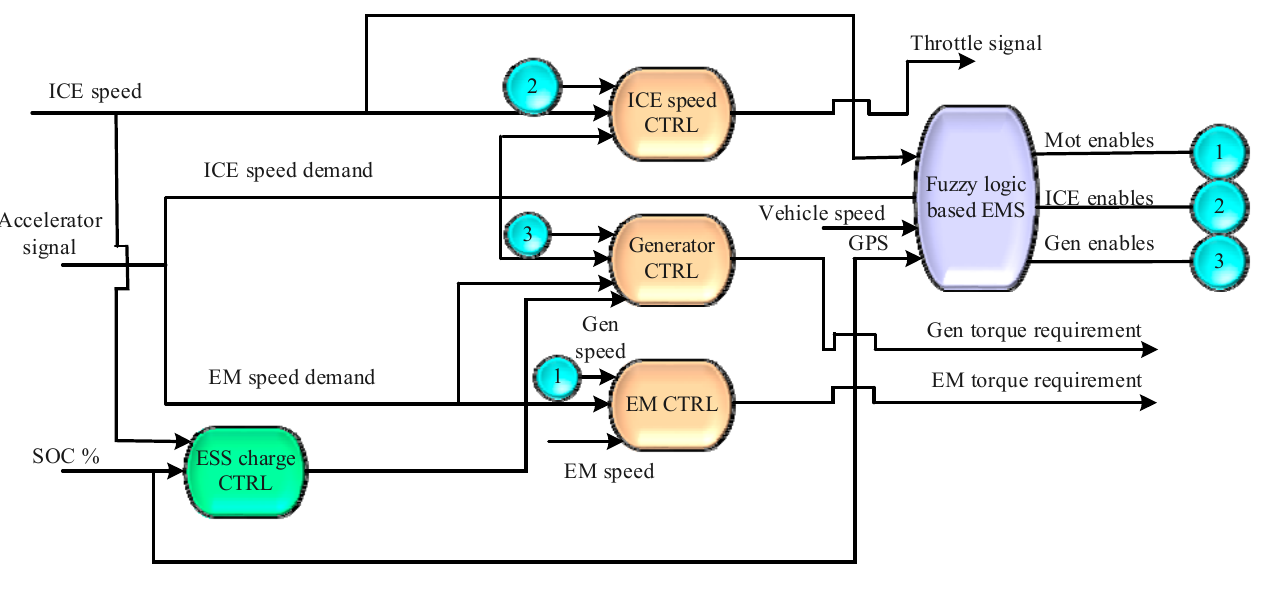
Figure 22. Fuzzy logic-based EMS controller block in EV applications.